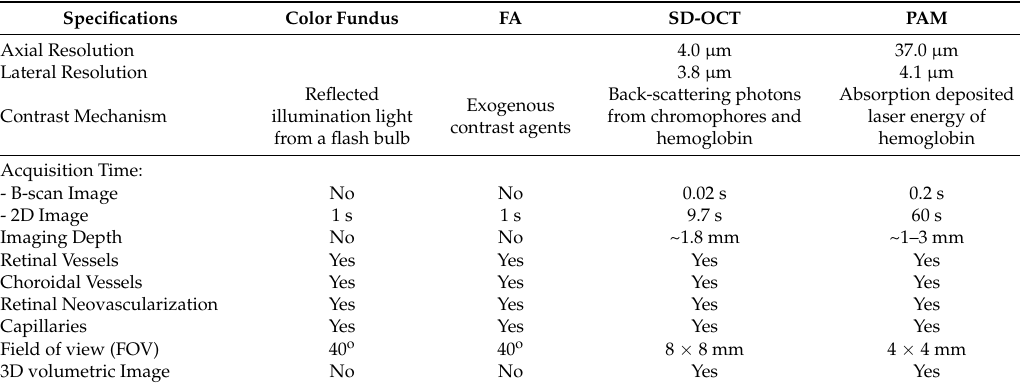
Table 2. Comparison of ocular imaging